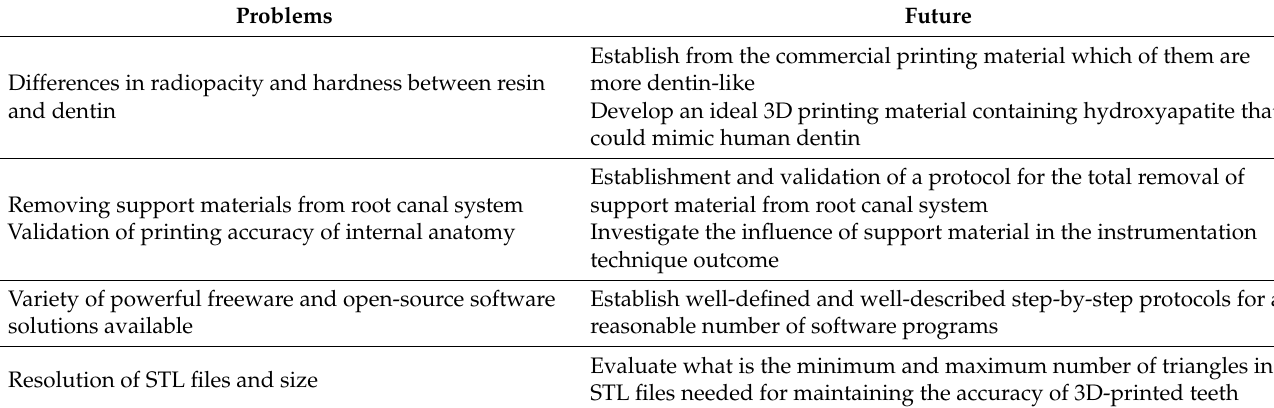
Table 1. Recommendations for future research of 3D-printed teeth in